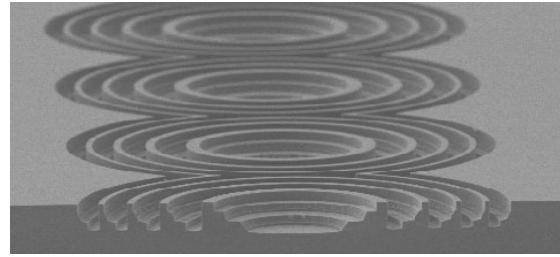
Fig.17 Array of Fresnel Lens Surface